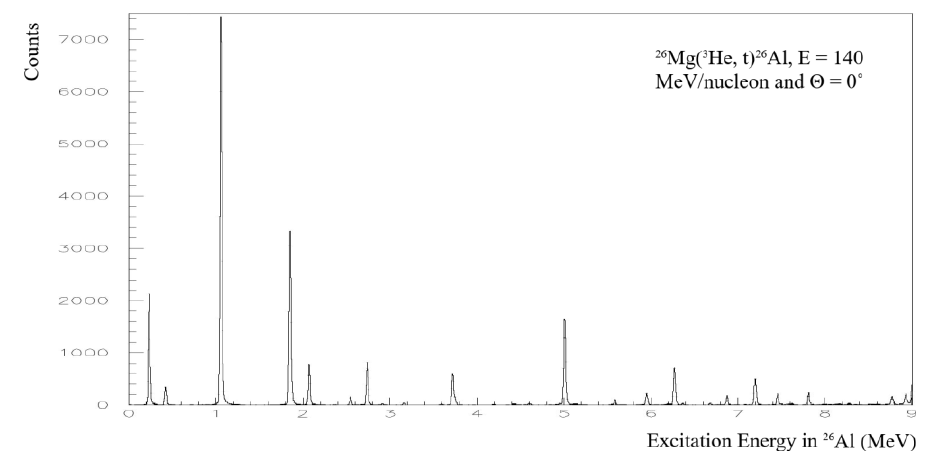
Fig. 3 The energy spectrum of the 26 Mg( 3 He, t) 26 Al reaction E x up to 9 MeV